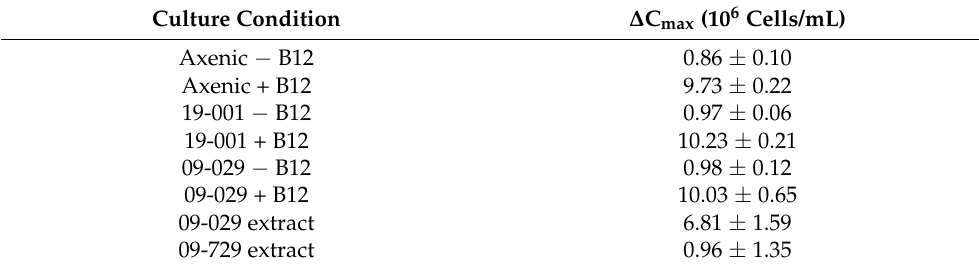
Table 2. Maximal biomass increase of T. lutea culture experiments with live bacteria or bacterial extracts, with or without cobalamin input.